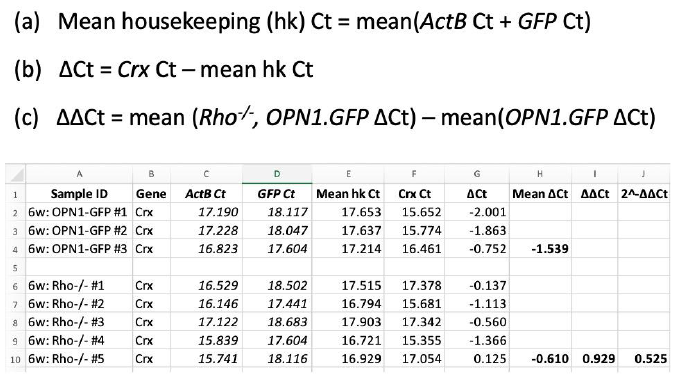
Figure A1. Detailed example of the ΔΔCt normalization of cone gene qPCR data using the published method [9]. The example gene here is Crx at the PNW6 time